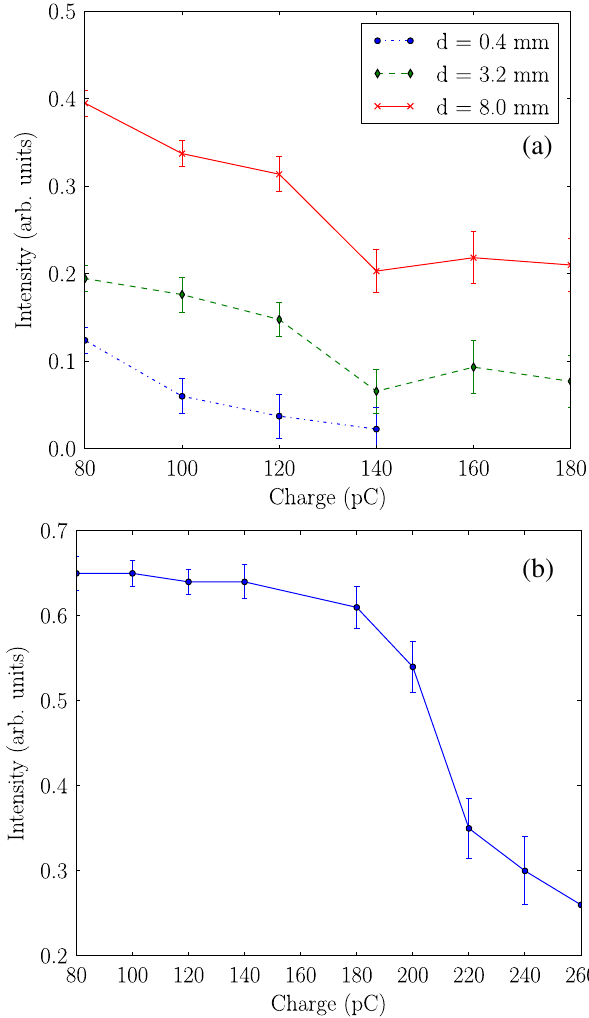
FIG. 10. False color measured 48 MeV electron beam patterns for various charges. From left to right and top to bottom: Q ¼ 60 , 100, 200, 300, 400, 500, 600, 700 pC with a matching-solenoid current of 240